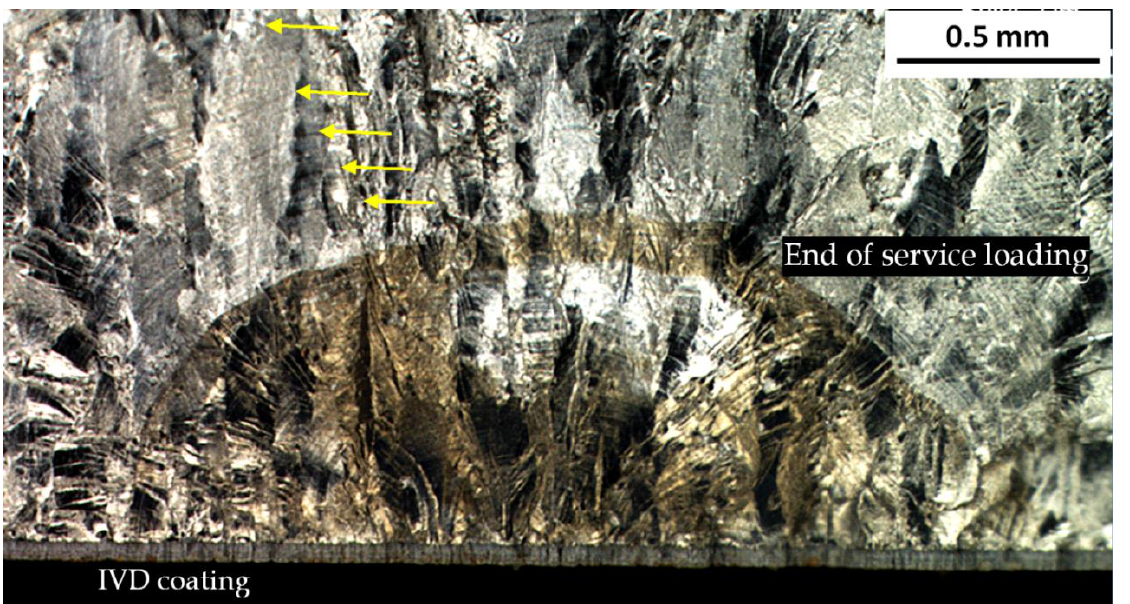
Figure 5. Optical colour fractograph of the C1 crack after cleaning to remove mild fracture surface oxidation. The yellowish discoloration represents the crack growth in service (see [14,43] for more details). The test spectrum consisted of flight blocks, and the yellow arrows point to some progression marks from the block loading.